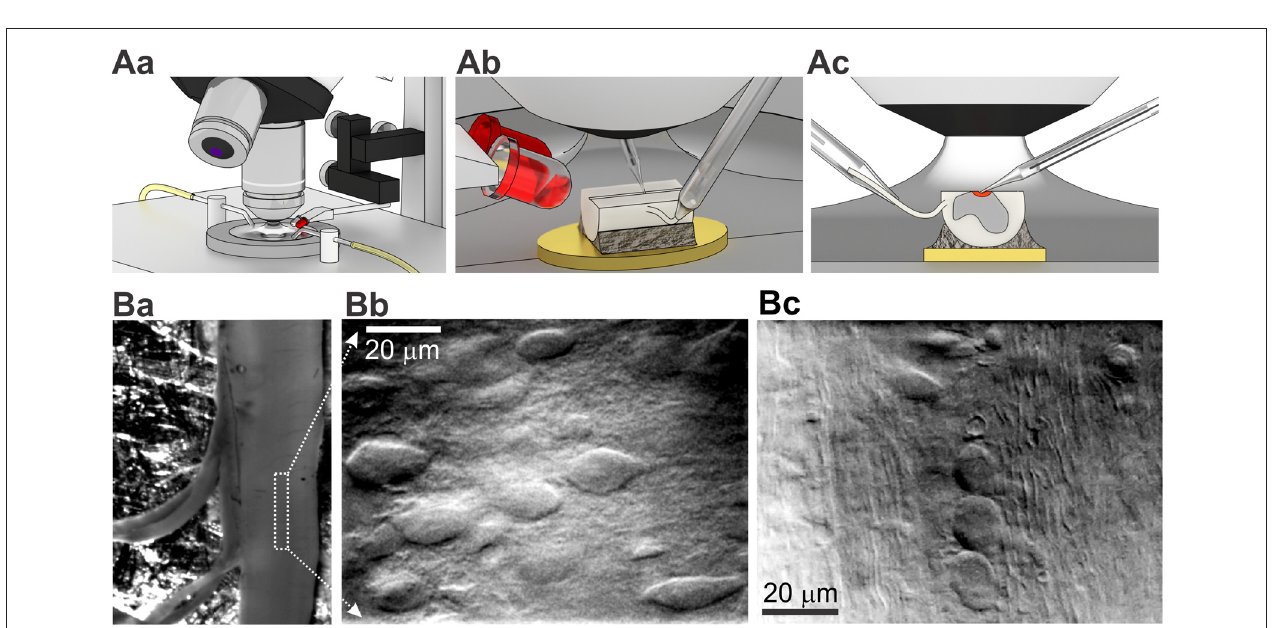
FIGURE 1 | A step-by-step spinal cord tissue preparation procedure. Schematic illustrations of pinning the dissected spinal cord tissue (Aa) , retrieving the spinal cord (Ab,Ac) and exposing the lamina X area (Ad) . (B) The spinal cord tissue preparation with exposed lamina X area and both dorsal and ventral roots attached.